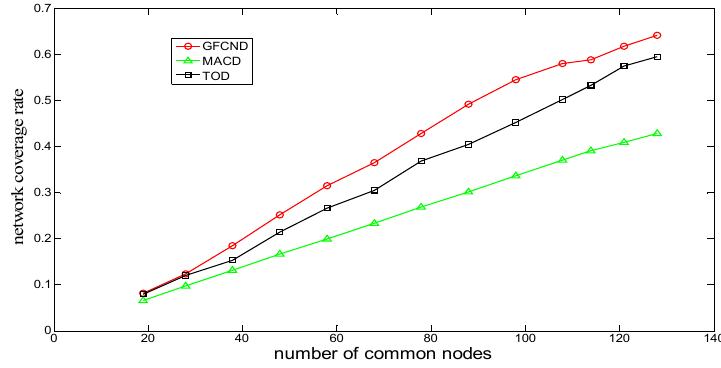
Figure 6. Network coverage rate for deployment algorithms.